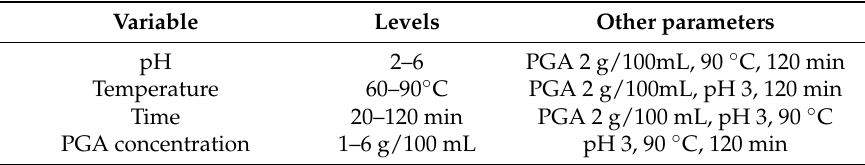
Table 2. Dyeing conditions of silk with the PGA/Glc reaction